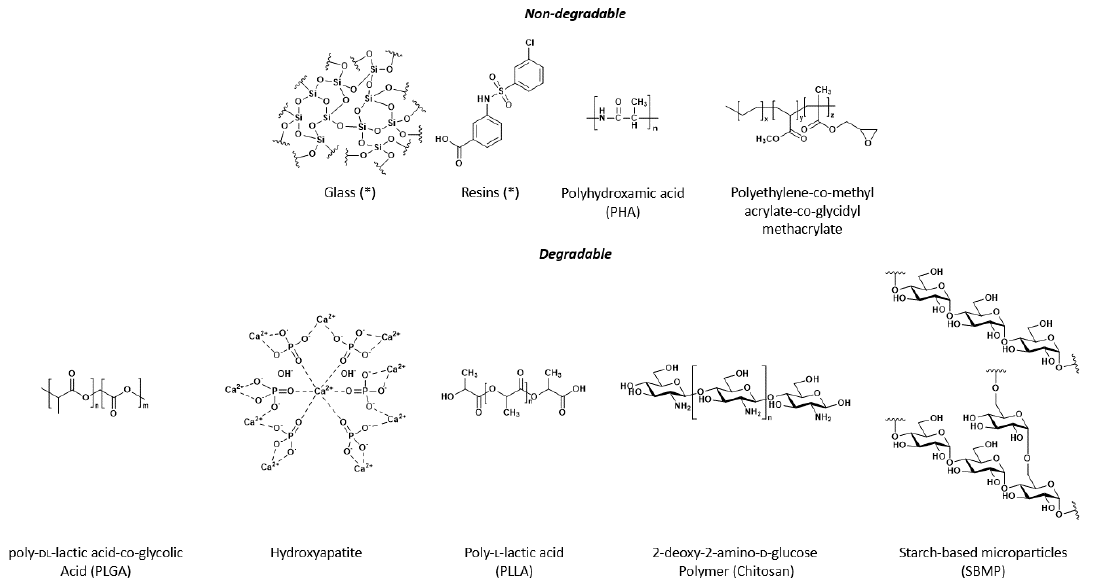
Figure 2. Schematic representations of building blocks and backbones for constructing radioactive microspheres. * = details binding unknown, insertion after mixing.